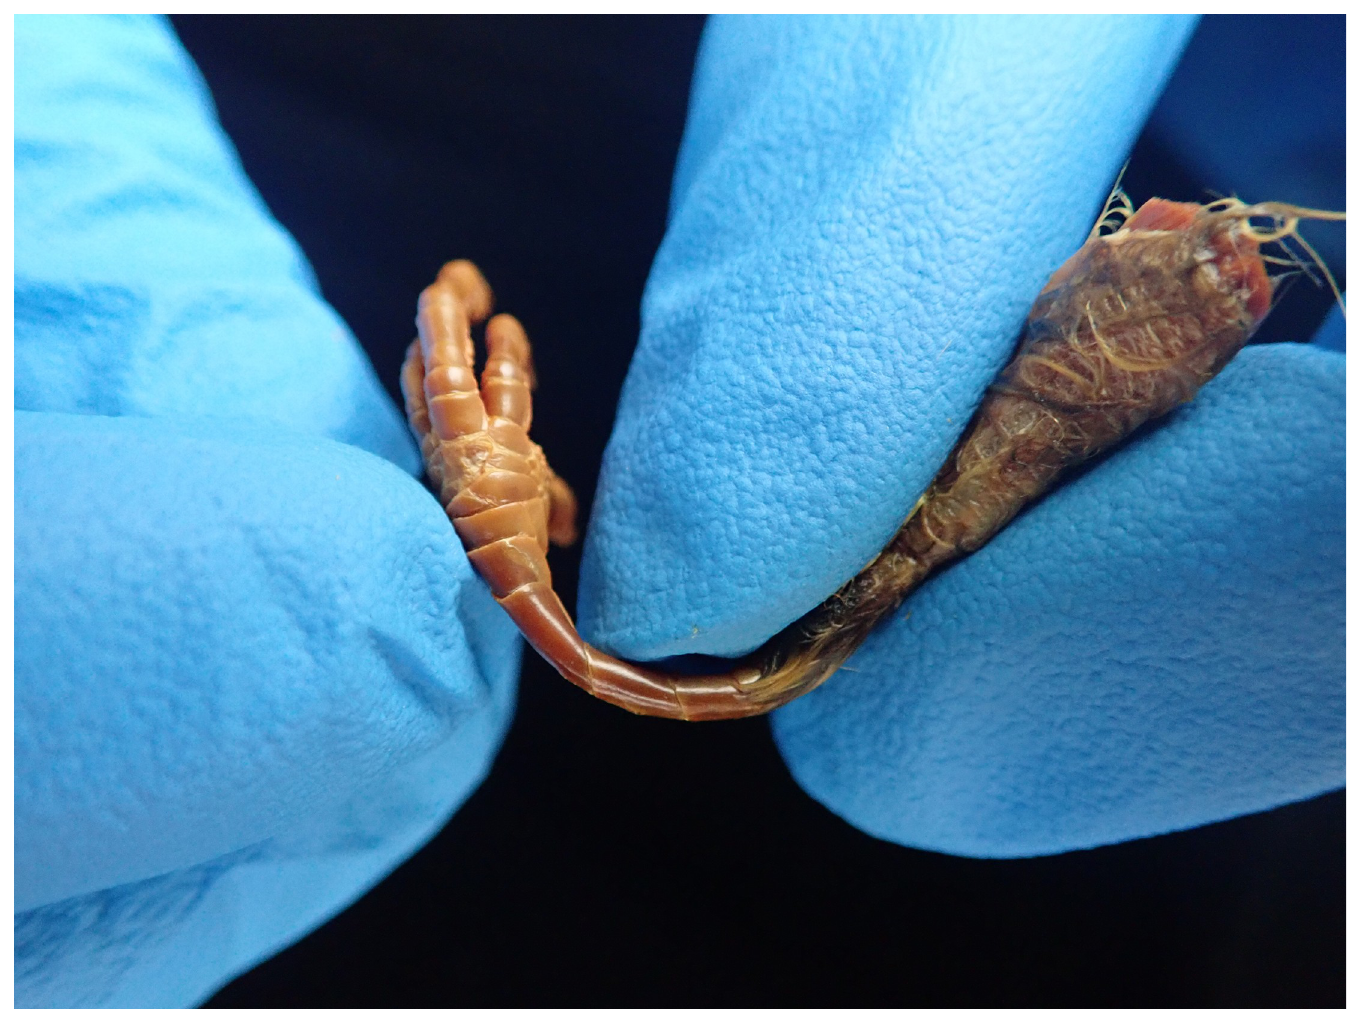
Fig 4. Demineralized leg. The leg of USNM 657964 after ten weeks in I 2 KI in water. The tarsometatarsus is being bent with very little effort, showing demineralization of the bone. https://doi.org/10.1371/journal.pone.0238783.g004 stain in which the first specimen stained with Lugol’s iodine (USNM 657964) soaked for seven weeks was measured as pH 3.20. The stain that was used to refresh this specimen and inter- acted with the specimen for three weeks until it was fully stained was measured as pH 2.83. All of these values for water-based stains used at varying stages of the experiment indicate Table 2. Assessment of the physical condition of specimens after staining. Stain Specimen Days Staining Days De-staining Long